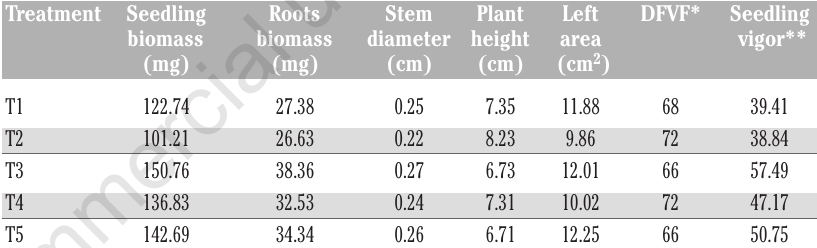
Table 2. Different treatments effect the morphological growth parameters of marigold seedling. Treatment Seedling